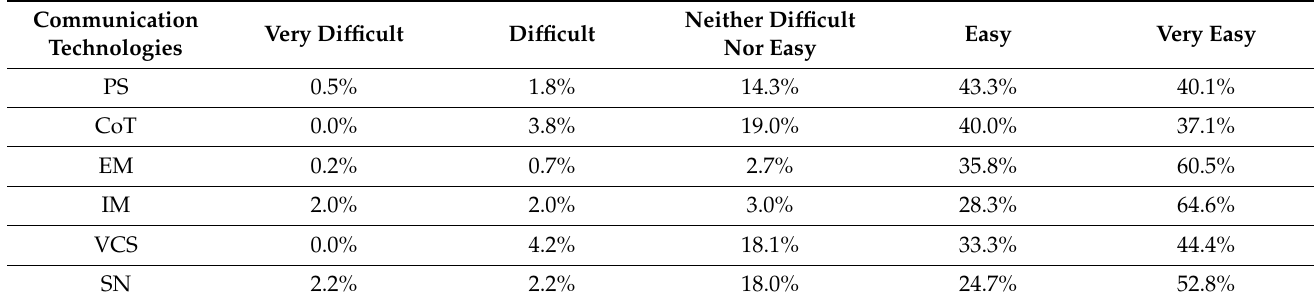
Table 10. Ease of use communication technologies by students.